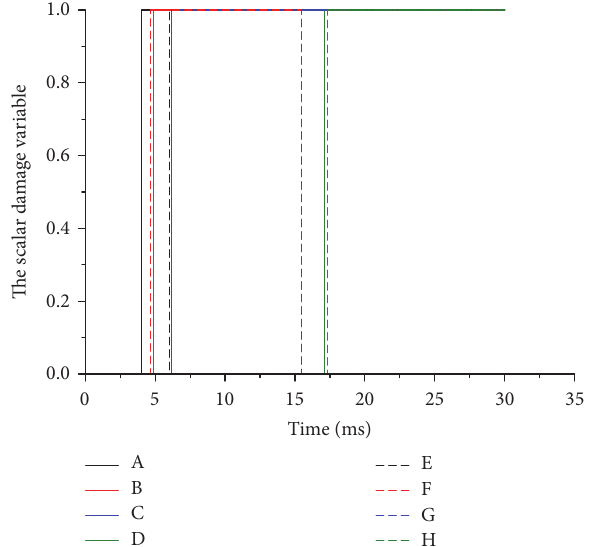
Figure 12: The scalar damage variable versus time curves for eight failure bolts. Table 5: Failure time and sequence of joints bolts. Failure